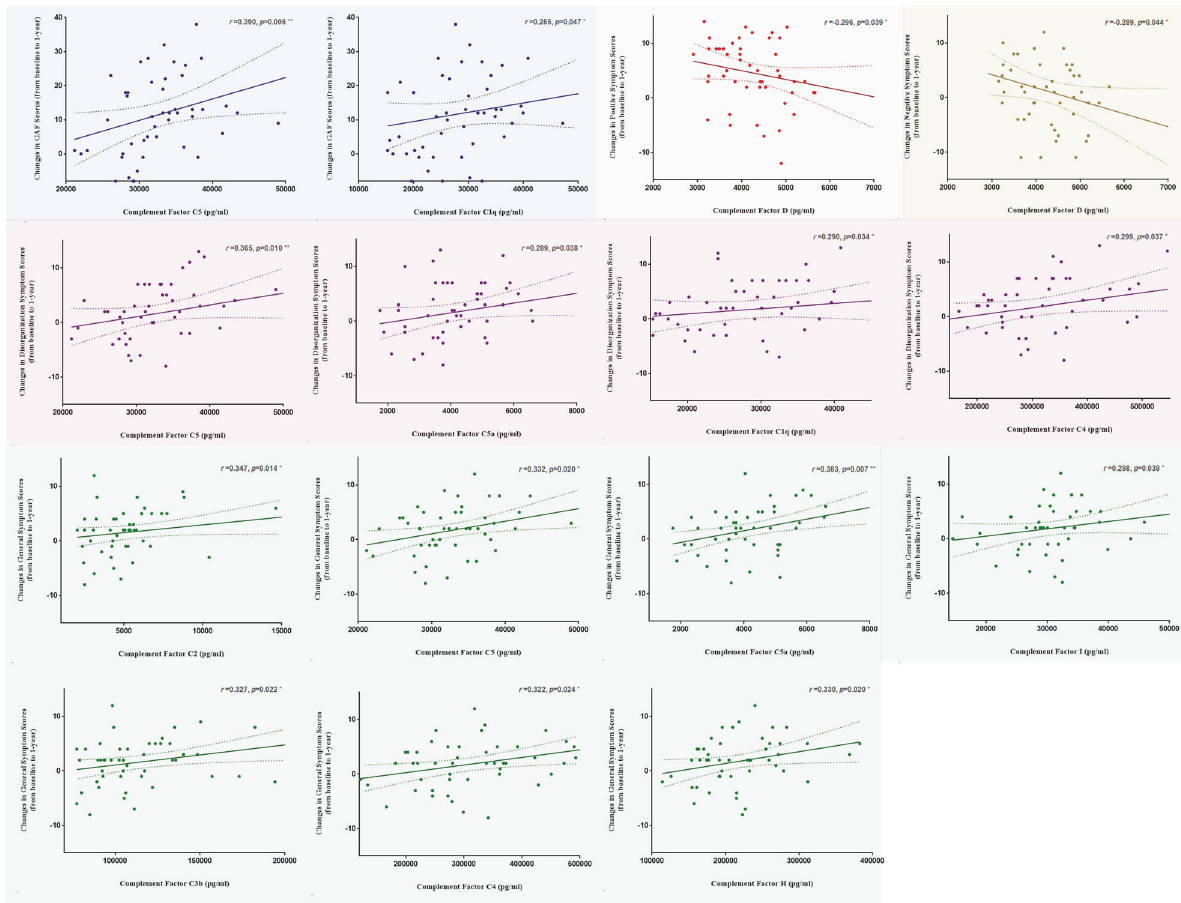
Fig. 3 Correlation analysis between functional and symptomatic changes and complement factors. Correlation (Spearman) between functional and symptomatic changes from baseline to 1-year and complement factors. GAF Global Assessment of Functioning, * p < 0.05; ** p < 0.01; *** p <